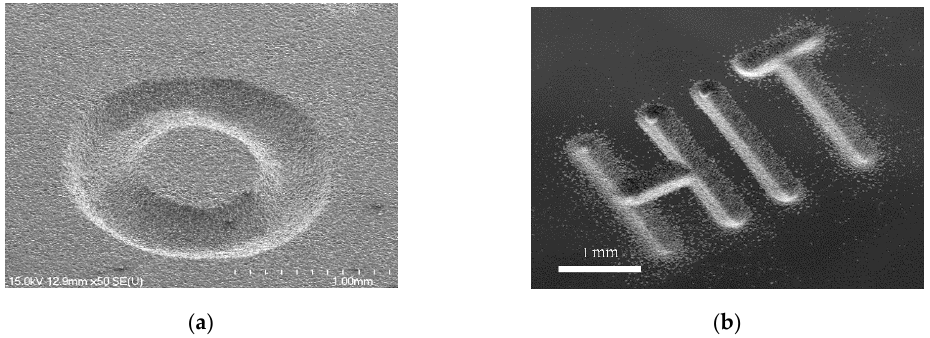
Figure 12. Sample result of arbitrary scanning-mode patterning performed using the developed process: ( a ) convex circular pillar and ( b ) “HIT” characters.